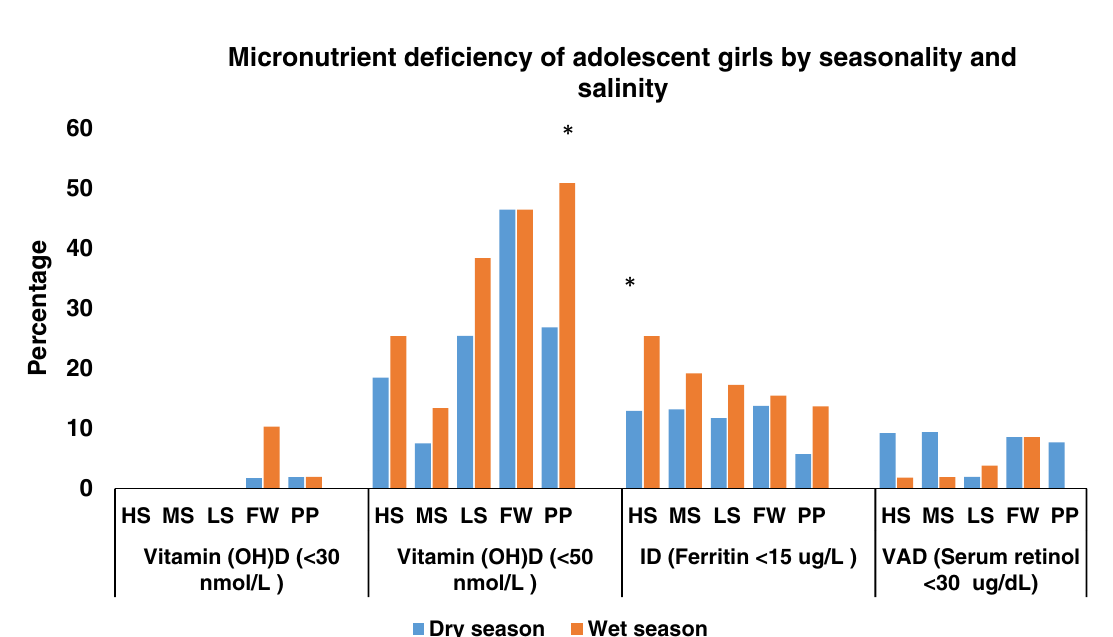
Figure 3. Micronutrient deficiency of adolescent girls by seasonality and salinity. Vitamin (OH) D deficiency (< 30 nmol/L), vitamin (OH) D insufficiency (< 50 nmol/L), Iron Deficiency (Ferritin < 15 ug/L) and VAD (Serum retinol < 30 ug/dL). Statistical significance ( P < 0.005) has been denoted by asterisk: *Pearson’s chi-square test. Note: Different agro-aquatic ecological zone- HS, High saline; MS, Medium saline; LS, Low saline; FW, Fresh water, and PP, Processing